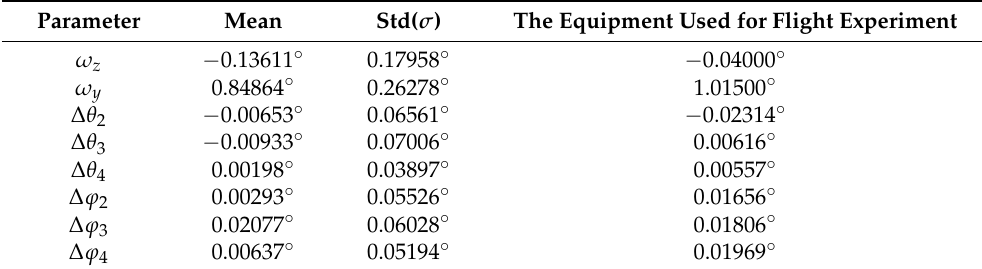
Table 2. Statistics of calibrated angle errors for LiDARs. Parameter